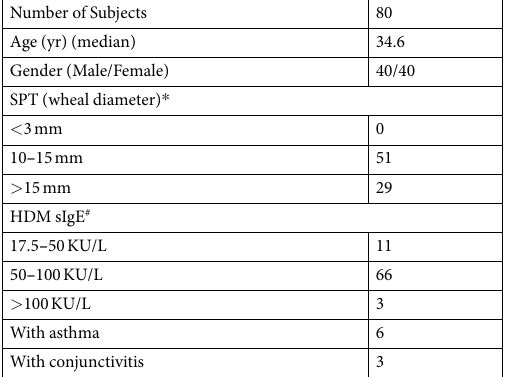
Table 1. Characteristics of AR patients. * A wheal diameter greater than 3 mm of the negative saline control was considered SPT positive. # The serum sIgE to HDM ( Der p and Der f ) was measured by the ImmunoCap test and a value of more than 0.35 kUA/l was considered a positive